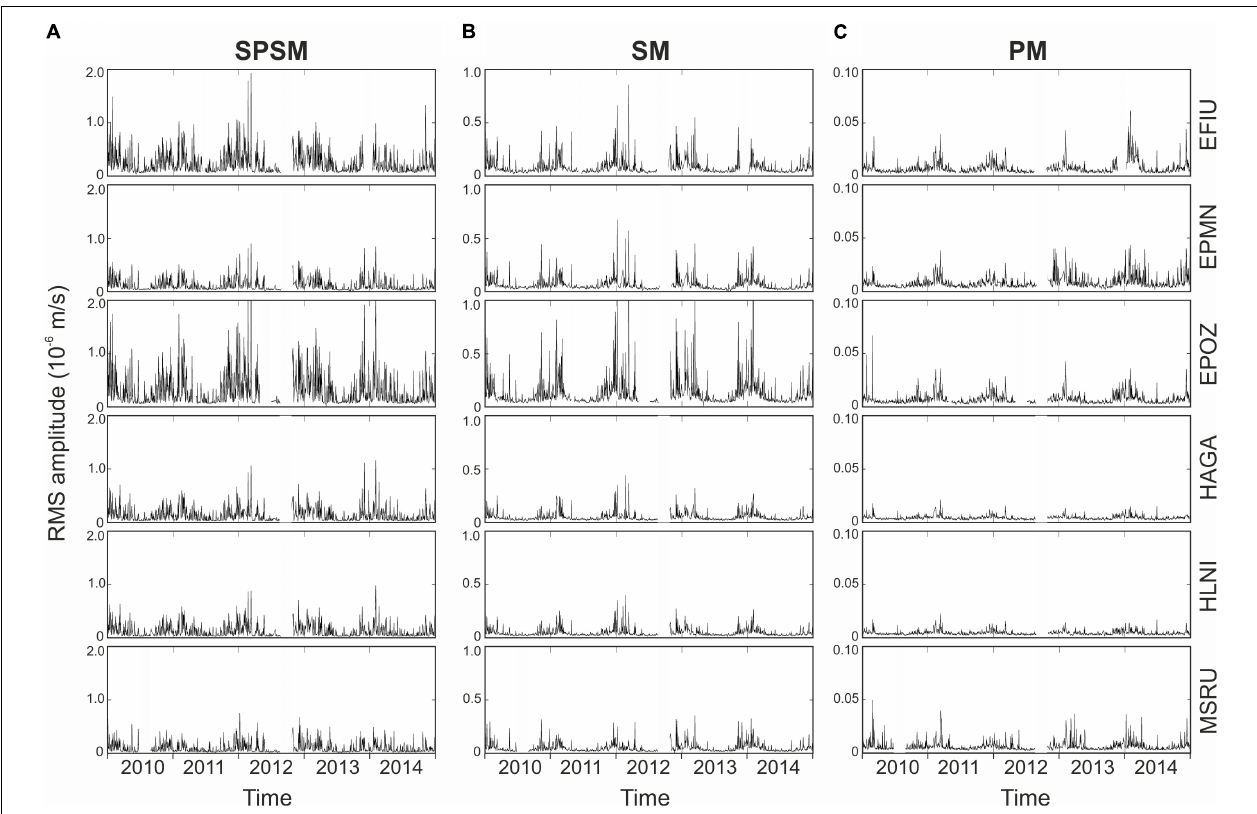
FIGURE 4 | RMS amplitude time series of the seismic signal recorded by the vertical component of the six considered stations and filtered in the bands (A) 2.5–5.0 s ( SPSM , short-period secondary microseism); (B) 5–10 s ( SM , secondary microseism); and (C) 13–20 s ( PM , primary microseism).